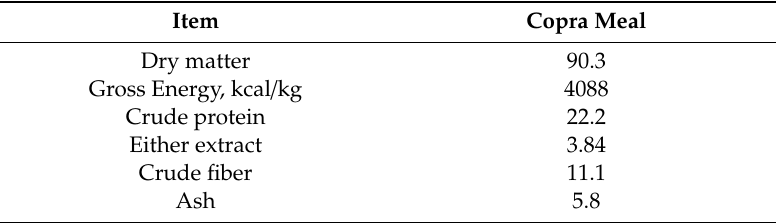
Table 1. The chemical composition of copra meal (%, as-fed basis).